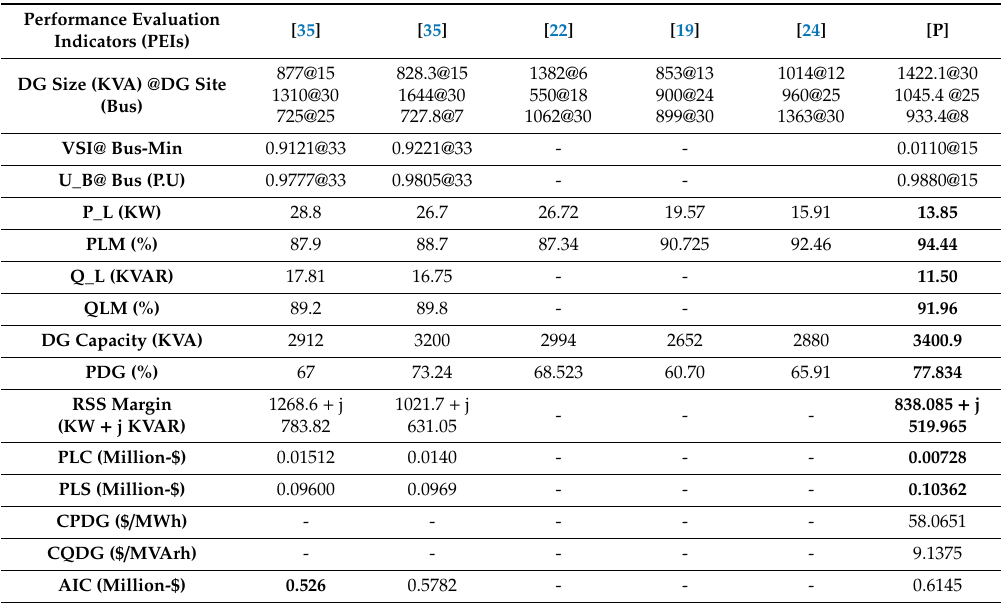
Table 13. Comparisons of results with various scenarios of Case 3 for 33-bus test system (DG@PF = 0.85 ± 3%). Performance Evaluation Indicators